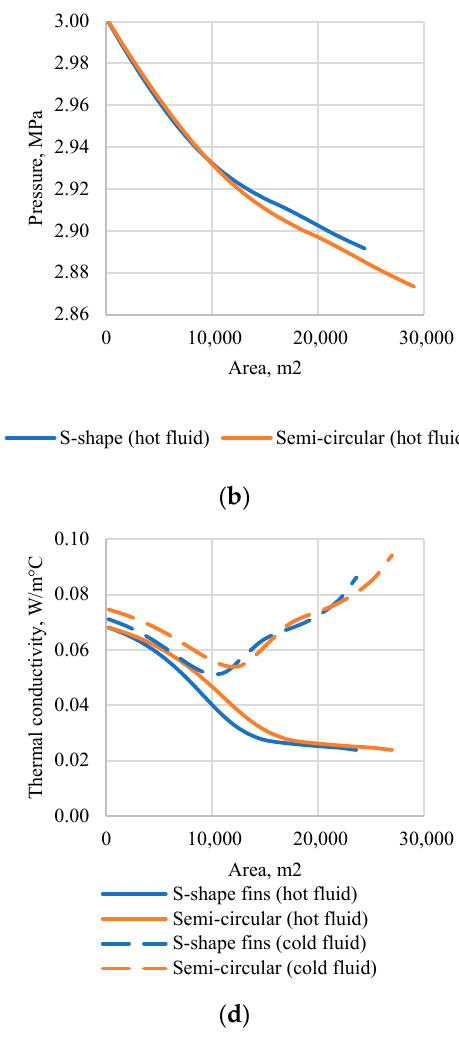
Figure 10. Distributions at hot flow velocity 5 m/s of: ( a ) heat transfer coefficient, ( b ) regenerator pressure losses; ( c ) fluid velocity; ( d ) thermal conductivity.